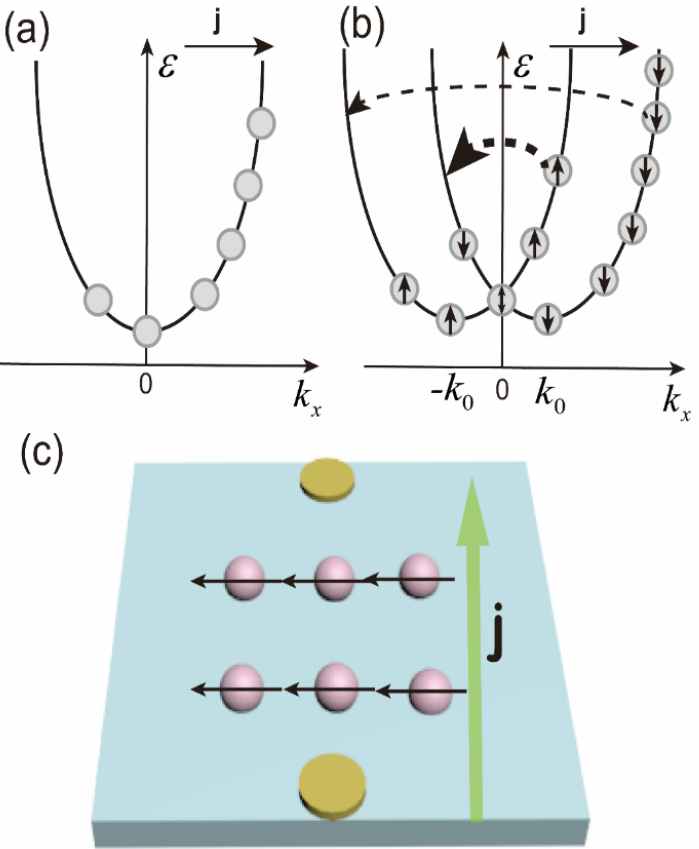
Figure 6. ( a ) Electron distribution at a stationary current flow stems from the acceleration in an electric field and momentum relaxation when the spin is degenerated. ( b ) Spin polarization is due to the spin-flip scattering. ( c ) The schematic of current-induced spin polarization. The pink sphere is photogenerated electrons, the green and black arrows are the electric field and spin polarization direction, respectively.